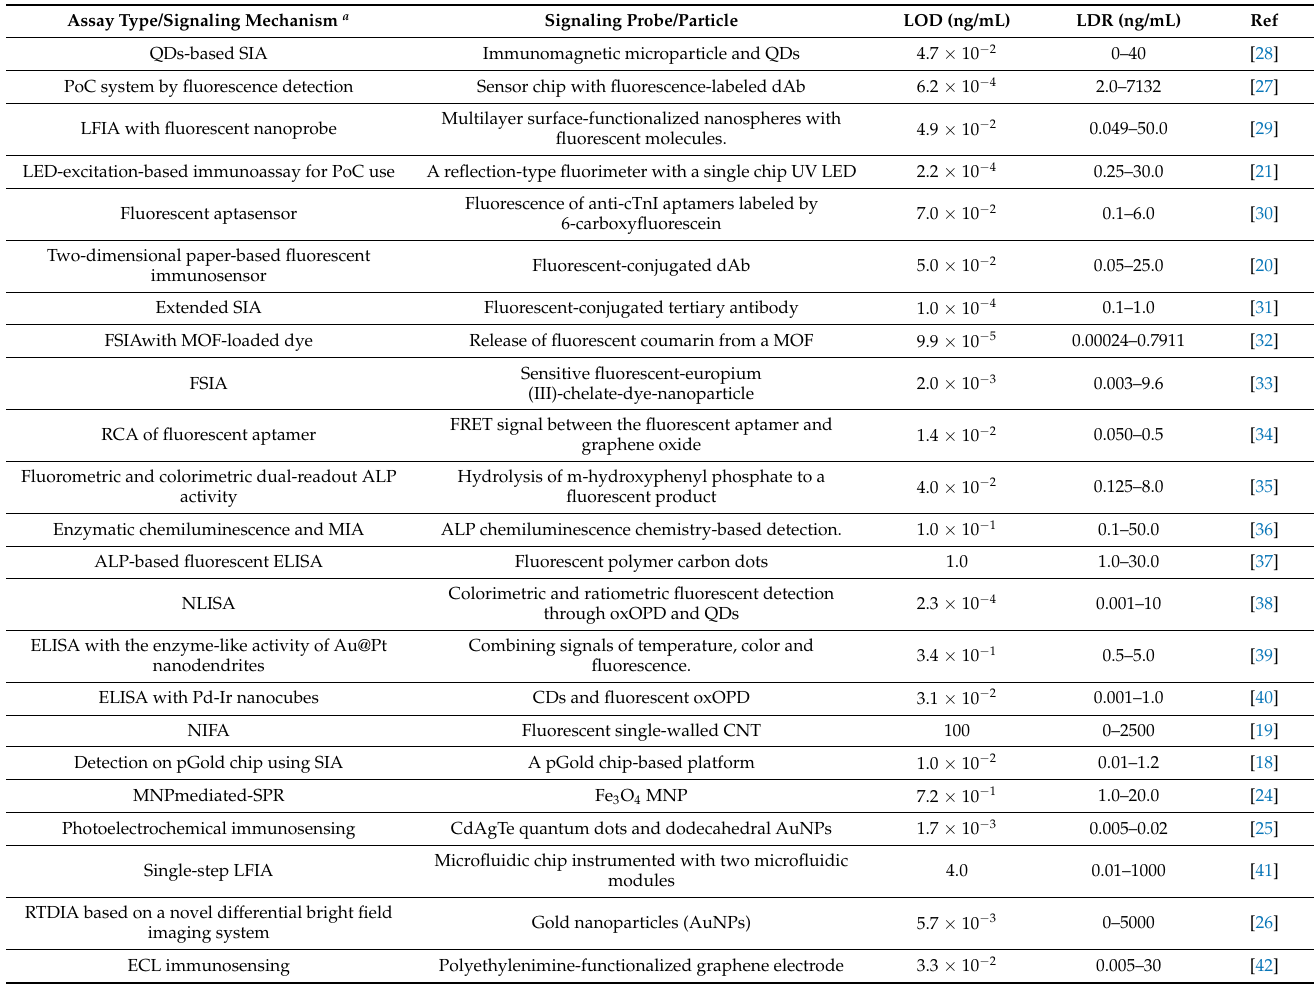
Table 2. A summary of reported immunoassays for